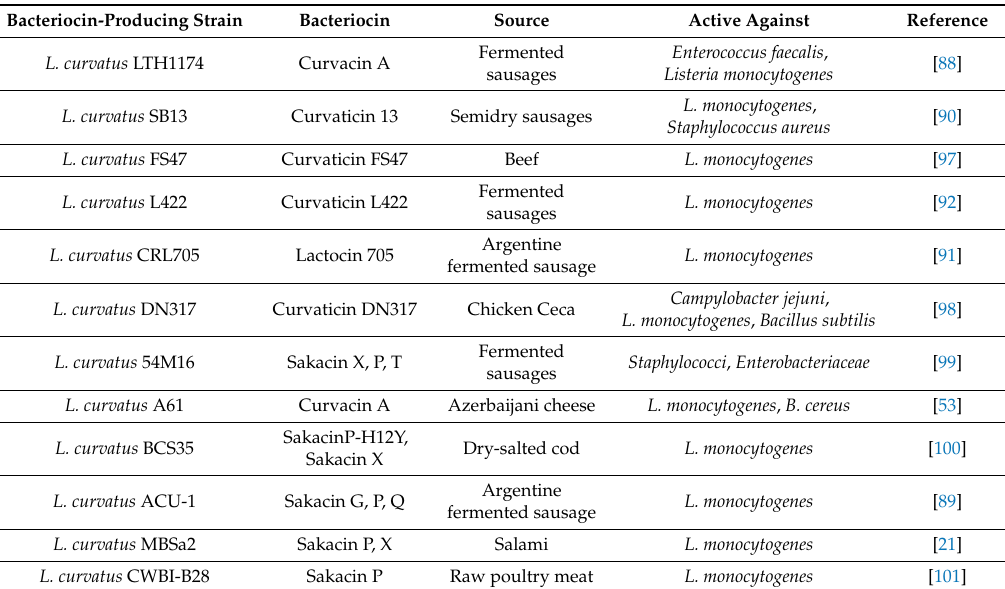
Table 2. Bacteriocins Produced by Latilactobacillus